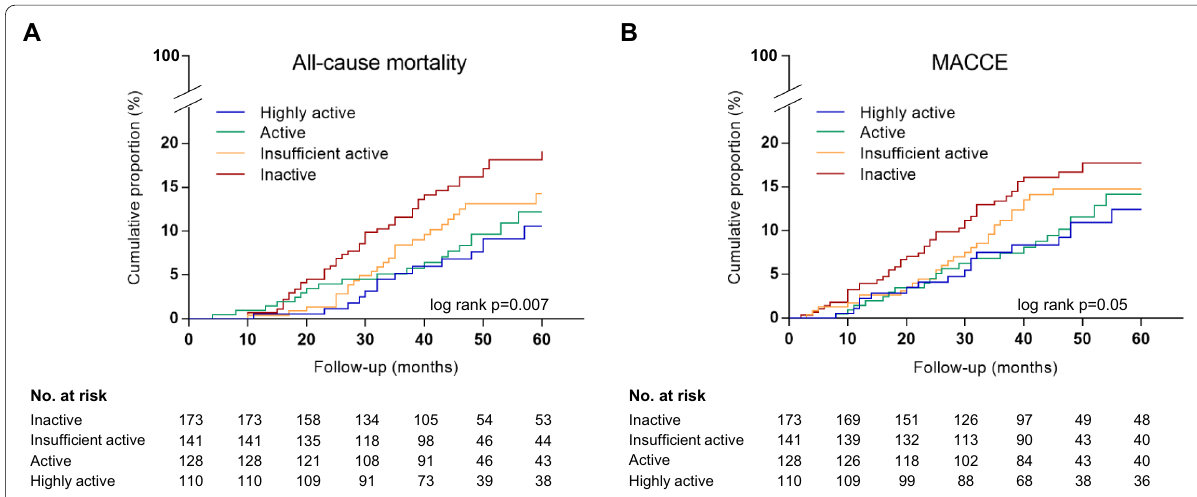
Fig. 2 Kaplan–Meier cumulative incidence of all‑cause mortality ( A ) and MACCE ( B ) in different physical activity levels as classified in the Physical Activity Guidelines. MACCE, major adverse cardiac and cerebrovascular